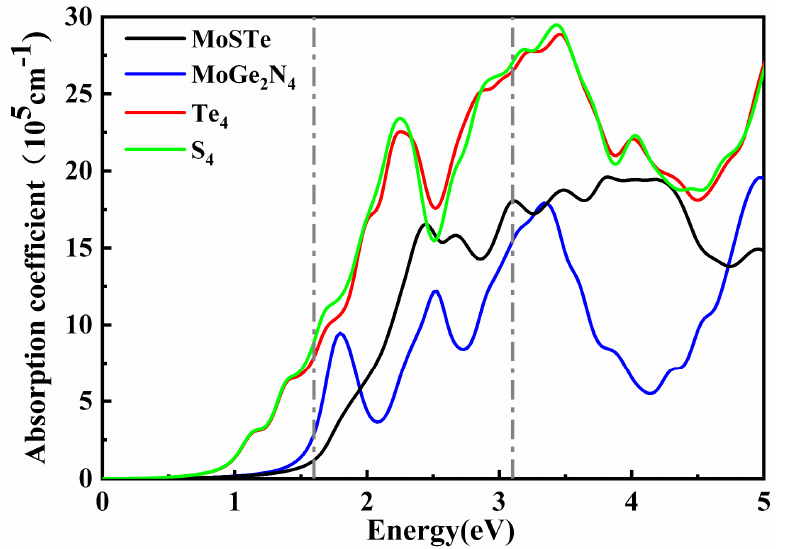
Figure 4. Optical absorption spectrum of Janus MoSTe, MoGe 2 N 4, Te 4 –MoSTe/MoGe 2 N 4 vdWH, and S 4 –MoSTe/MoGe 2 N 4 vdWH.